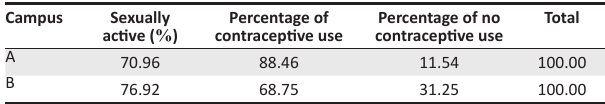
TABLE 4: Percentage of sexual activity and contraceptive use.